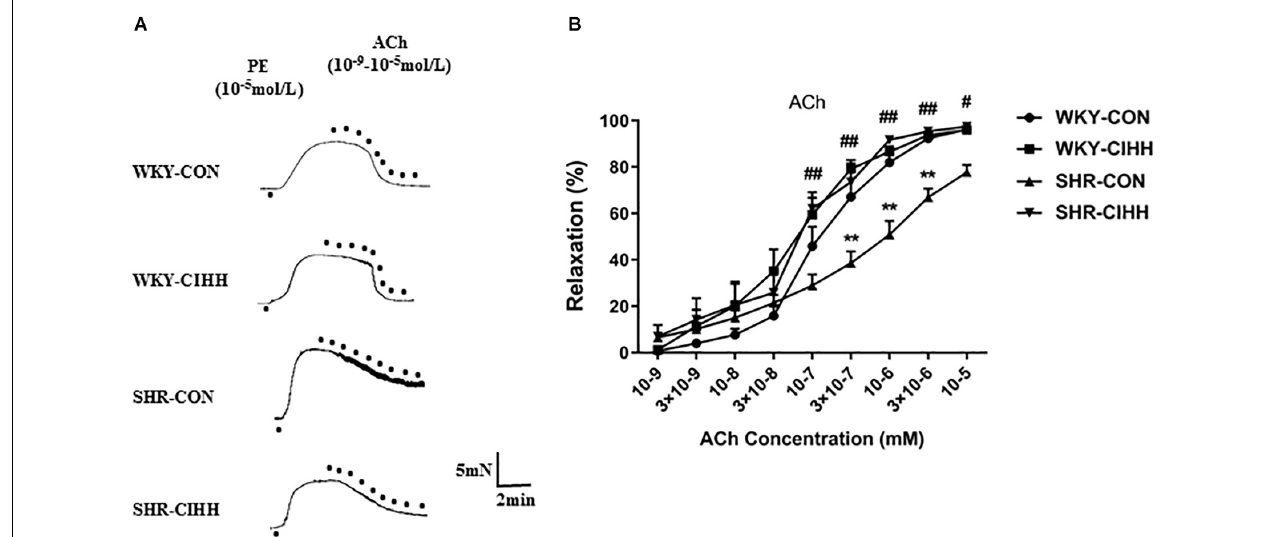
FIGURE 6 | Effect of chronic intermittent hypobaric hypoxia (CIHH) on ACh-induced relaxation in the mesenteric arteries of spontaneously hypertensive rats (SHRs).Representative traces (A) and summarized data (B) of mesenteric arteries in response to different concentrations of ACh after precontracted with PE. Data are expressed as mean ± SEM; SHR-CON: control SHR ( n = 16); SHR-CIHH: SHR with CIHH ( n = 14); WKY-CON: control WKY rats ( n = 12); WKY-CIHH: WKY rats with CIHH ( n = 12). ** P < 0.01 vs. WKY-CON, # P < 0.05, ## P < 0.01 vs. SHR-CON (two-way ANOVA).